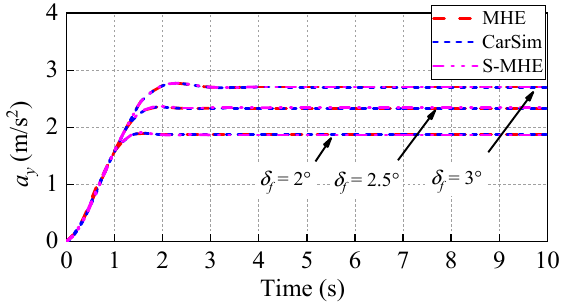
Figure 14. Lateral acceleration.